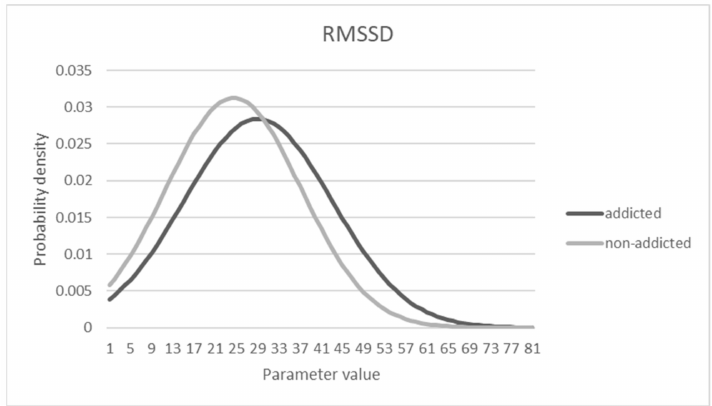
Figure 5. Probability density distribution of RMSSD